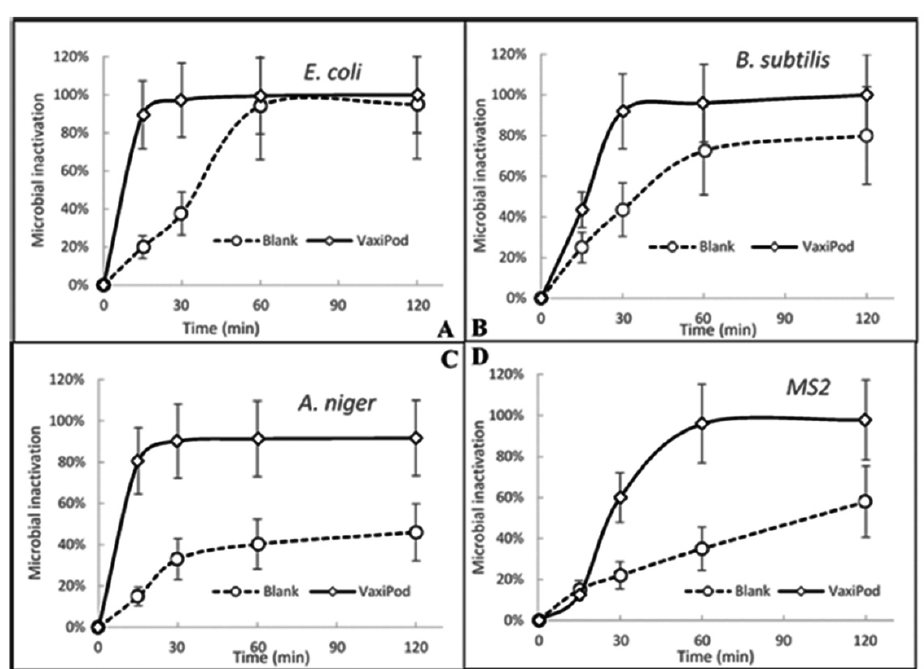
Figure 6. Microbial inactivation of ( A ) E.coli, ( B ) B. subtilis, ( C ) A. niger , ( D ) MS2 on the filter surface. Error bars represent STDEV of at least 3 experimental runs.